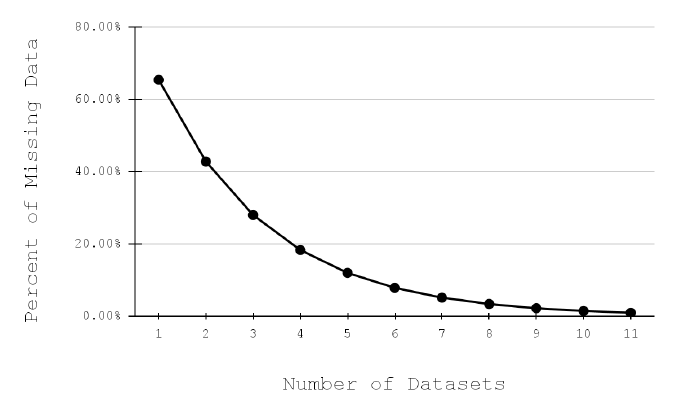
Figure 7. Multiplicative percent nullity versus number of